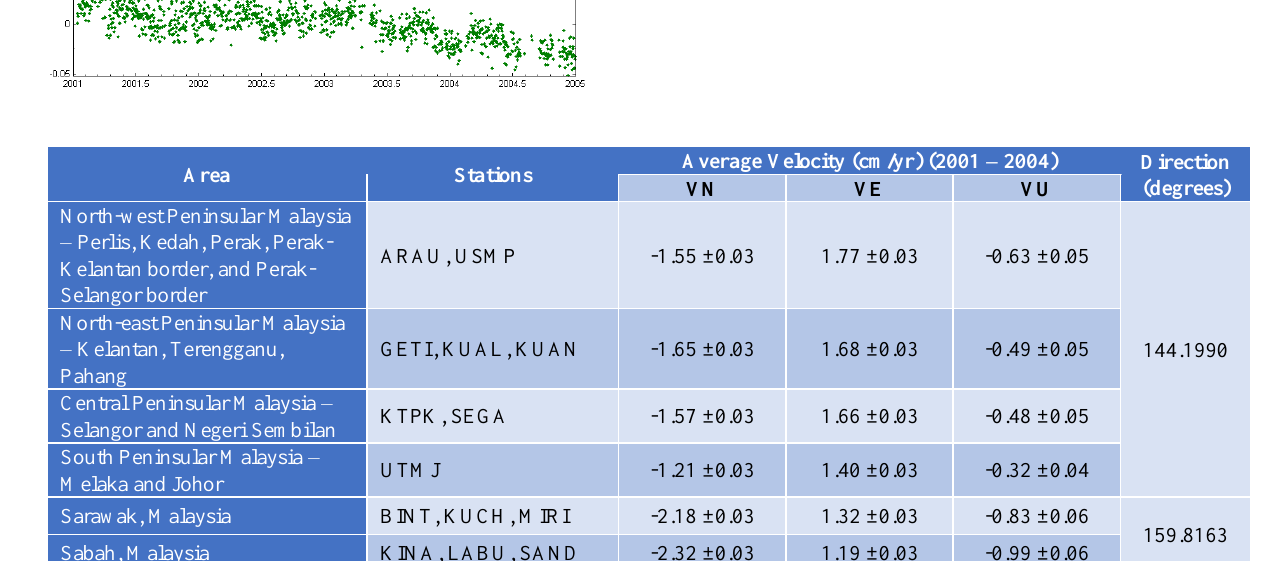
Figure 3. The time series of MASS daily solutions from 2001 to 2004 for the four selected stations and their standard deviations. With reference to figure 3, the time series shows no co-seismic displacements between years 2001 and 2004 indicating no significant earthquakes had occurred. However, the time series is heavily affected by annual and semi-annual effects; nonetheless, with solutions spanning 4 years, these effects are considerably reduced for estimating the velocity vectors (Blewitt and Lavallée, 2001).